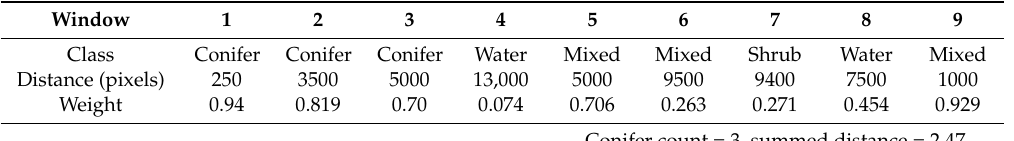
Table 4. Example of class weighting and label selection from windows.